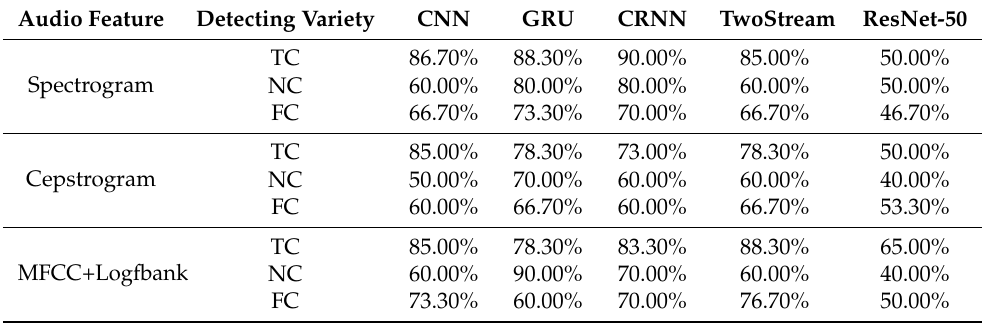
Table 5. Result of using a mixture of calls from the three varieties of chickens for training and performing sex detection on each of the 3 varieties of chickens.